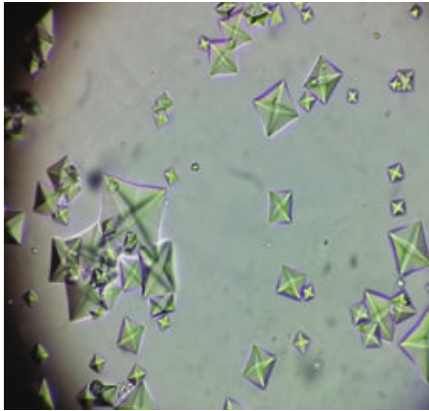
Figure 1: Picture of fruit of Averrhoa bilimbi .